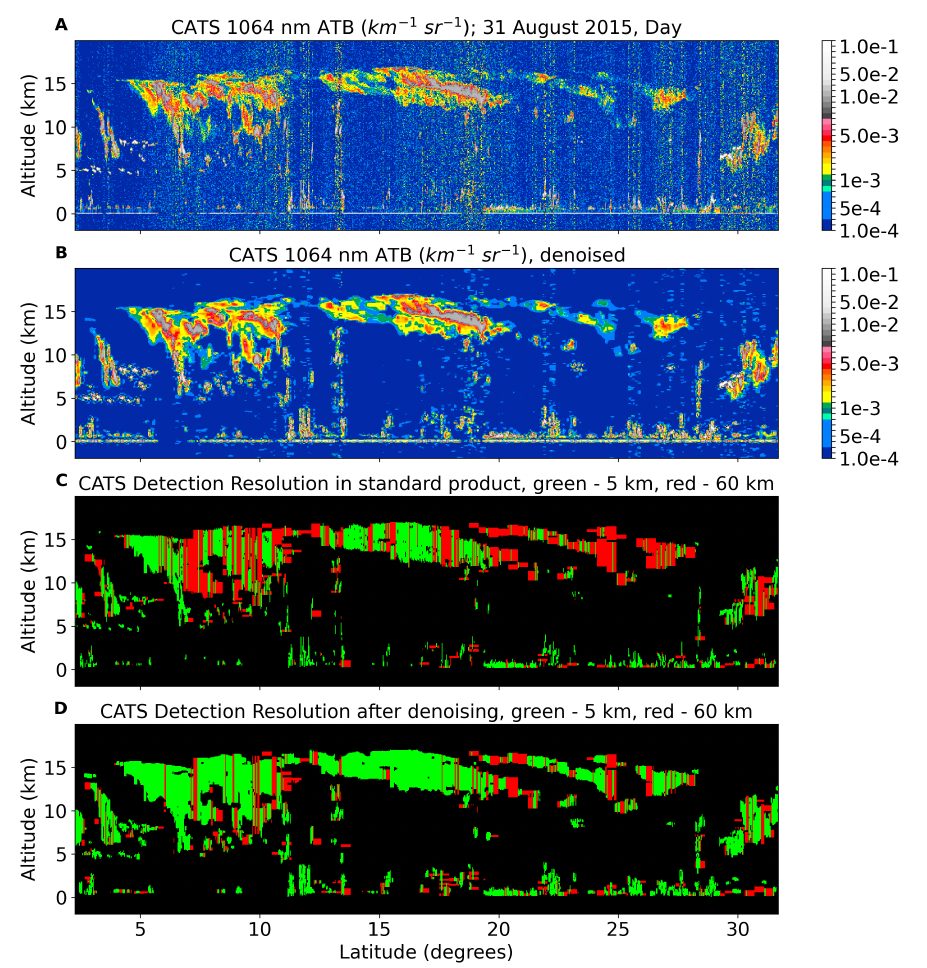
Figure 7. The CATS 1064 nm attenuated total backscatter (ATB) averaged horizontally to 5 km ( A ) and then after the wavelet denoising algorithm was applied ( B ). as well as the layers reported in the V3-00 data products before the denoising ( C ) and after ( D ) detected at both 5 km (green) and 60 km (red) for a case on 31 August